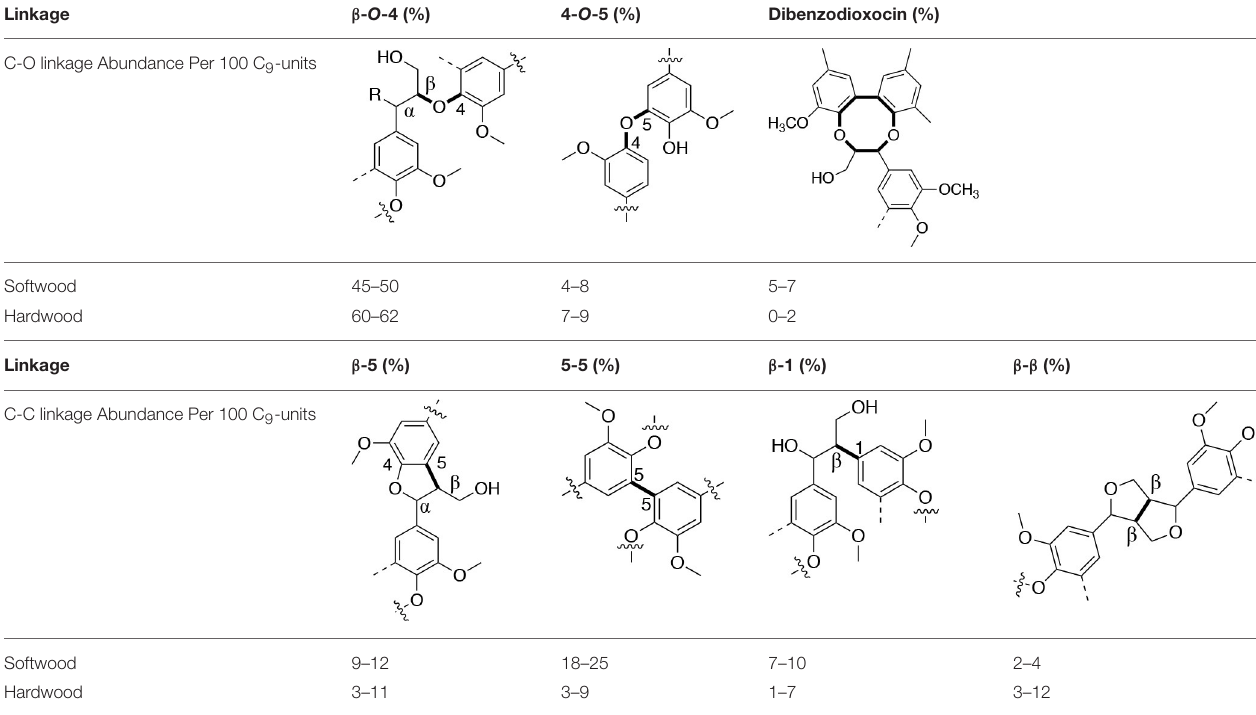
TABLE 1 | Reported abundance of major linkages in softwood and hardwood lignins (Chakar and Ragauskas, 2004; Zakzeski et al., 2010). Linkage